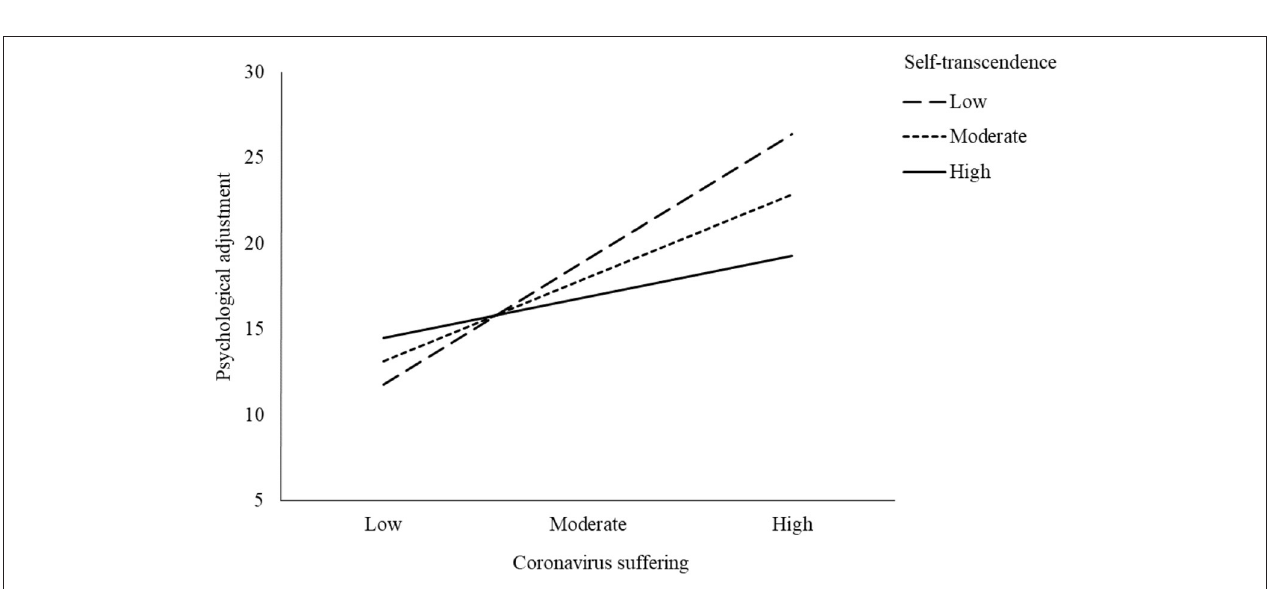
FIGURE 10 | Moderating effect of self-transcendence on the link between coronavirus-related suffering and psychological adjustment problems.